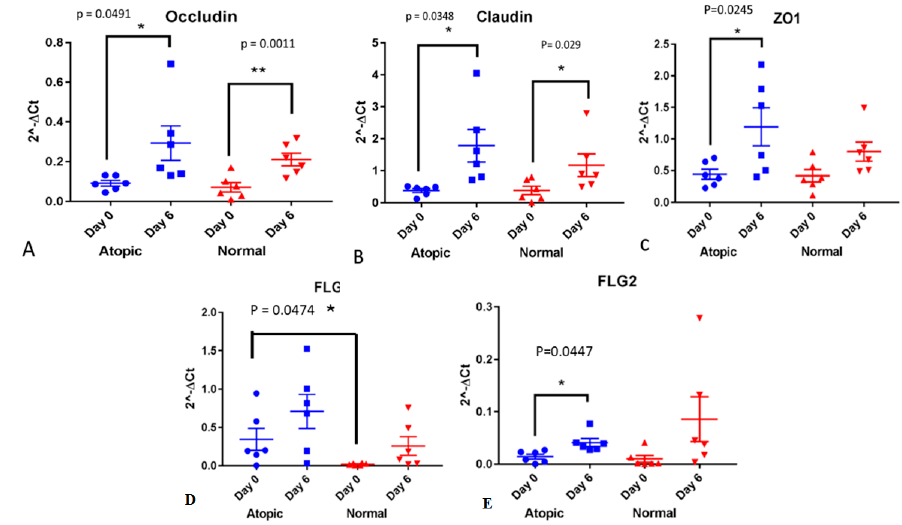
Figure 2. Gene expression of Tight Junction proteins and filaggrins on first day of confluence, day 0 (DO) and day 6 (D6). All numbers and statistical analyses are presented as 2^(-deltaCt). Note that the y axes on these graphs use different scales ( A – E ). * indicates p values that are p < 0.05 and ** is for p < 0.005.